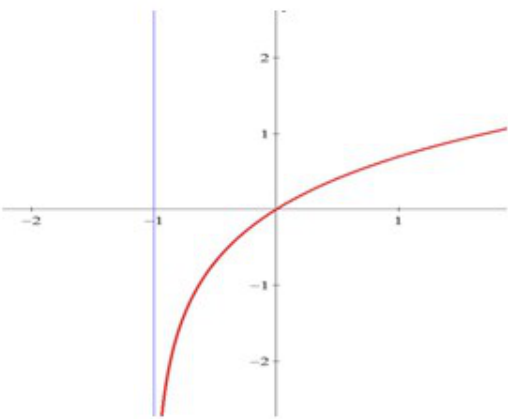
Figure 8. Graphical representaton of g ( f ( x )) =1n( x + 1) , mentoned in Problem